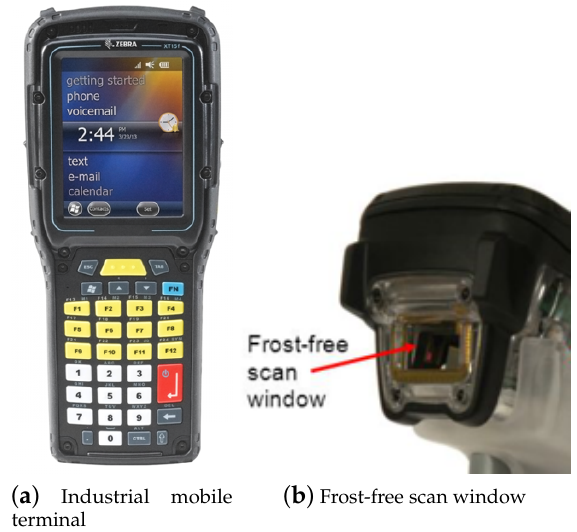
Figure 1. A typical industrial mobile terminal used for low-temperature operation: Zebra Omnii XT15f.